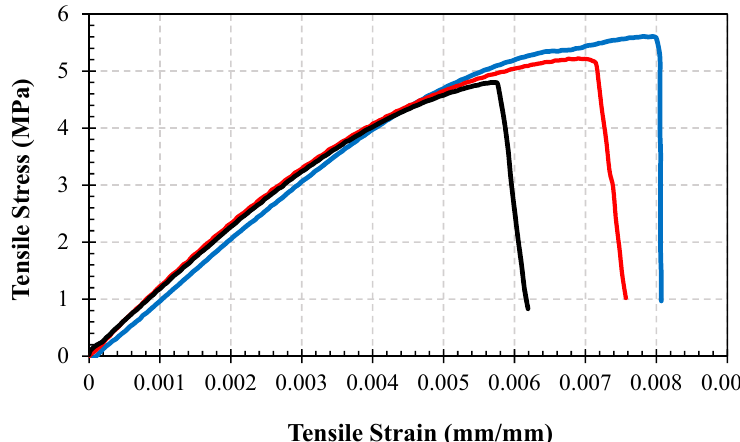
Figure 5. Plot of Stress vs Strain for three specimens, black for 0°, red for 45° and blue for 90° cutting samples.